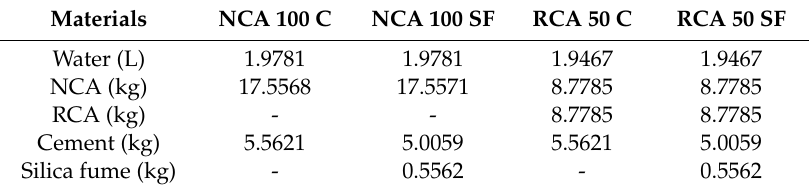
Table 4. Previous concrete mixtures for a specimen of 15 × 15 × 50 cm (0.0113 m 3